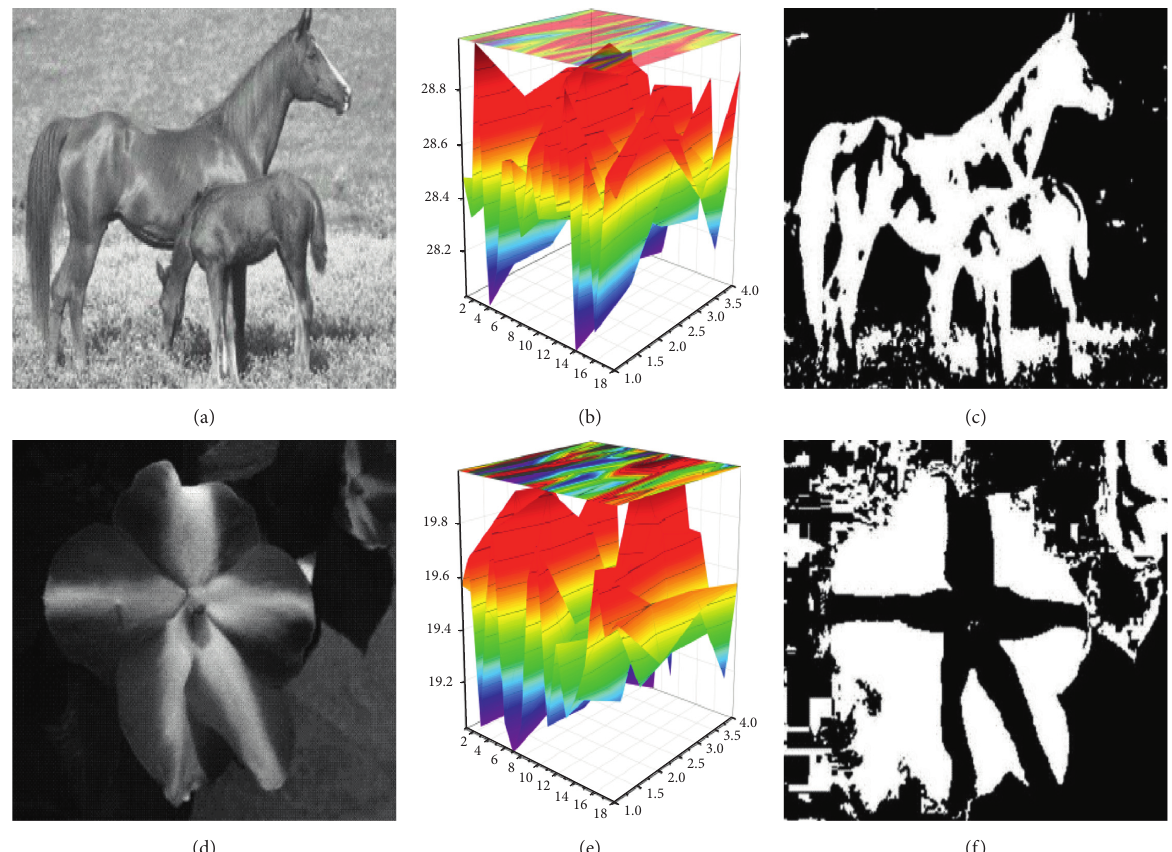
Figure 2: Grayscale image of Lena without noise